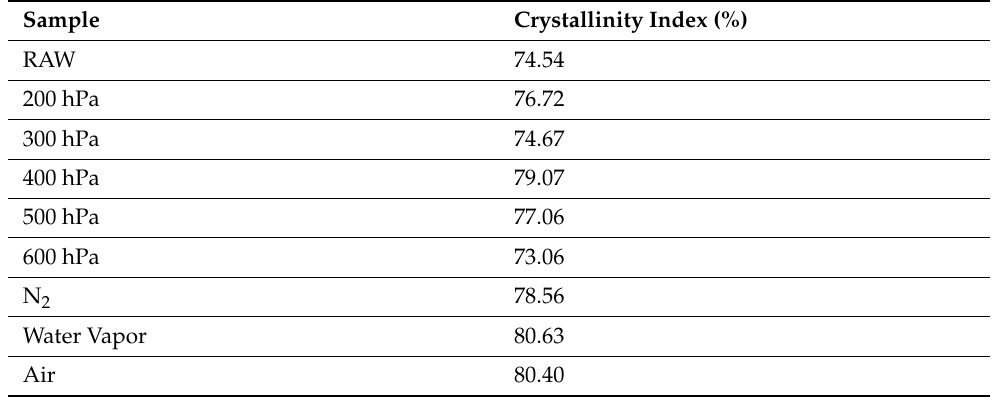
Figure 10. X-ray diffractograms of poplar samples treated under ( a ) reduced pressure and ( b ) different atmospheres. Table 3. Calculated crystallinity index for poplar wood samples torrefied under different pressures (200 hPa to 600 hPa) and different atmospheres (N 2 , water vapor, and air).